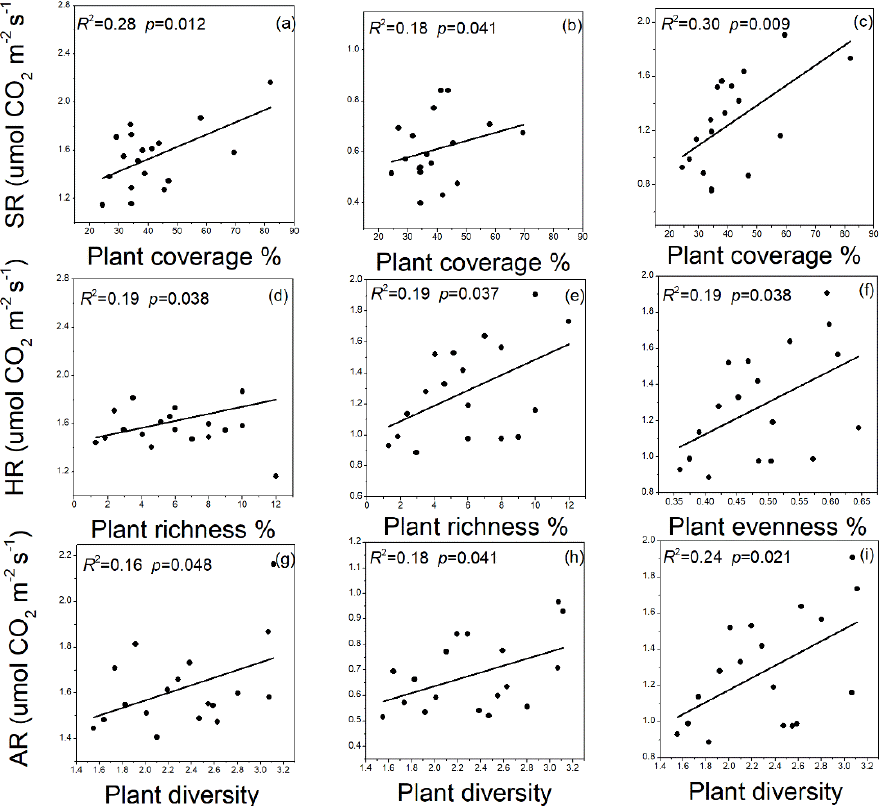
Figure 6. Linear Regression between SR and plant coverage in RP40 ( a ), RP20 ( b ), and in RP15 ( c ); between HR and plant richness in RP40 ( d ), RP20 ( e ), and in RP15 ( f ); between AR and plant diversity in RP40 ( g ), RP20 ( h ), and in RP15 ( i ); Soil respiration (SR); Soil heterotrophic respiration (HR); Soil autotrophic respiration (AR).